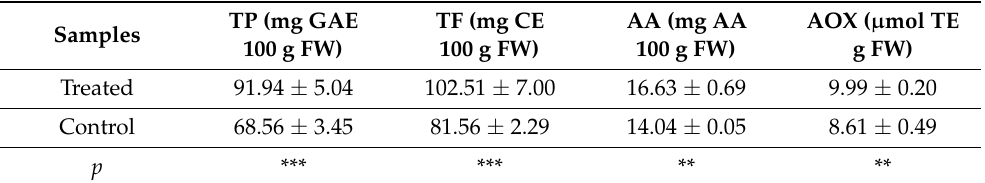
Table 2. Bioactive compounds in the rocket leaves treated with Bortan (Treated) and in the untreated samples (Control).